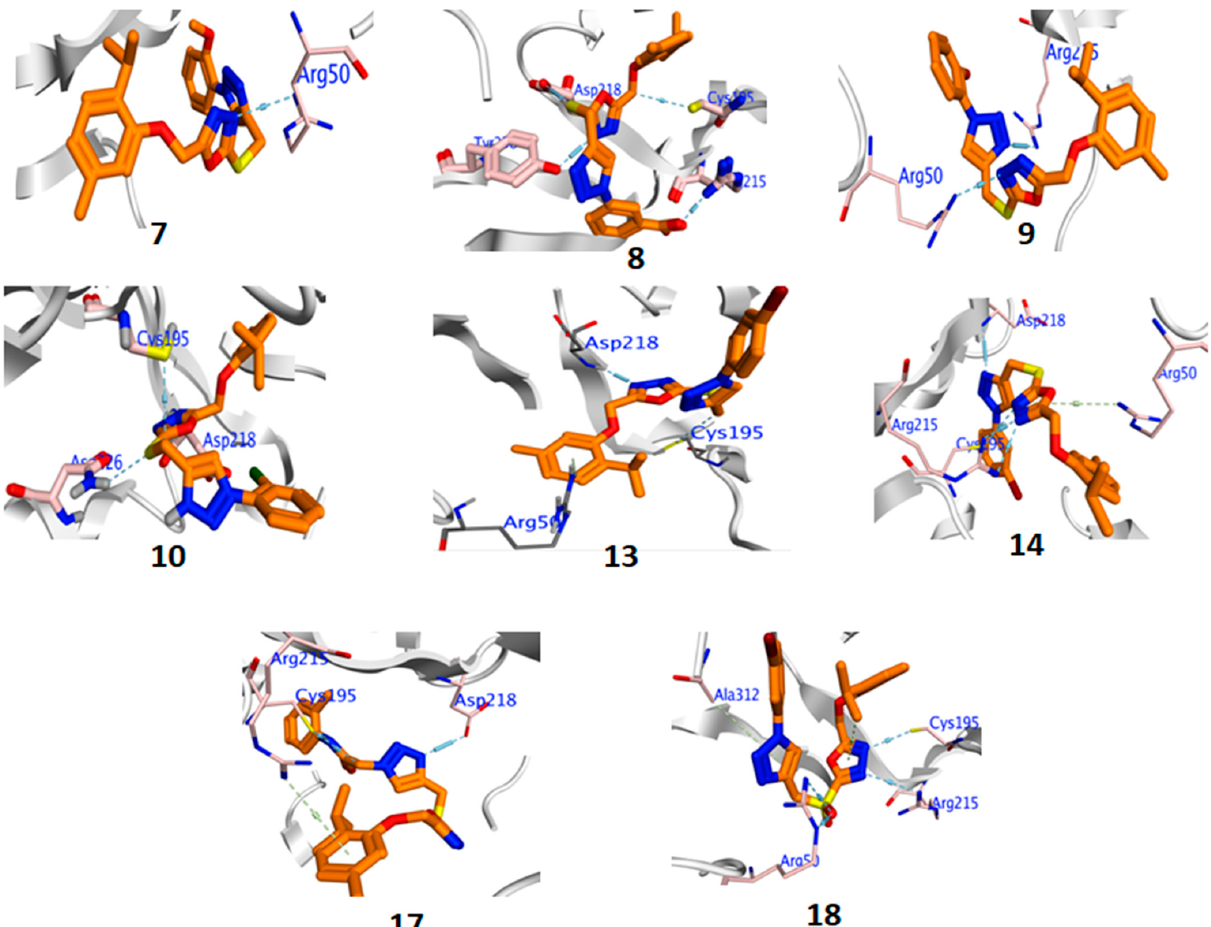
Figure 4. Binding interaction of active compounds against TS (6QXG). DNA Gyrase B